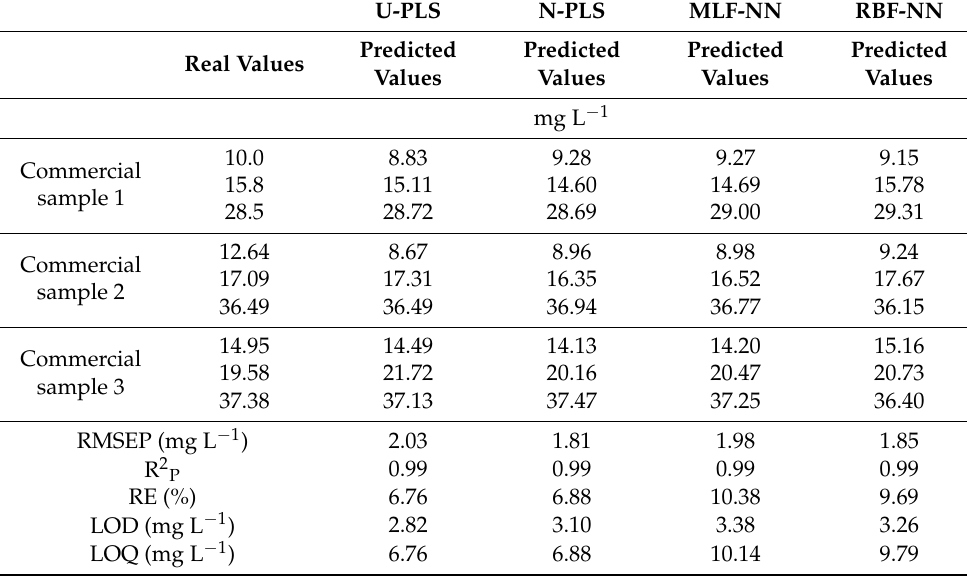
Table 4. Predicted results for ASA commercial samples and the respective figures of merit for each chemometric